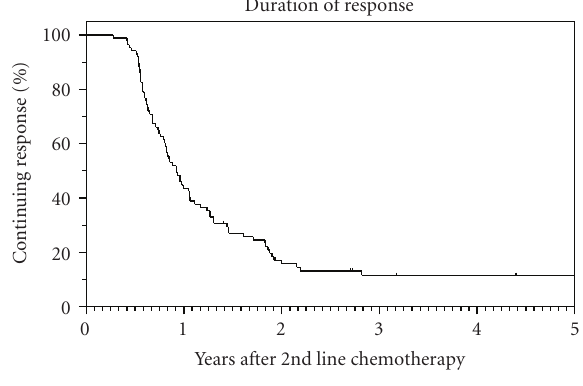
Figure 1: Duration of disease